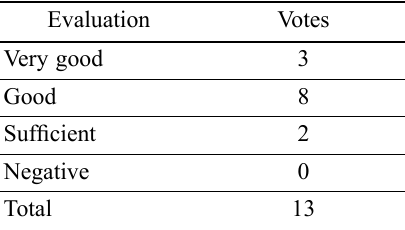
Table 10. Evaluation of ICT